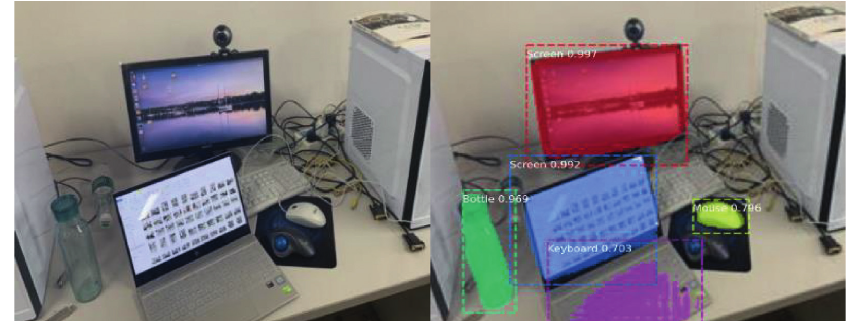
Figure 12: Operation images of the